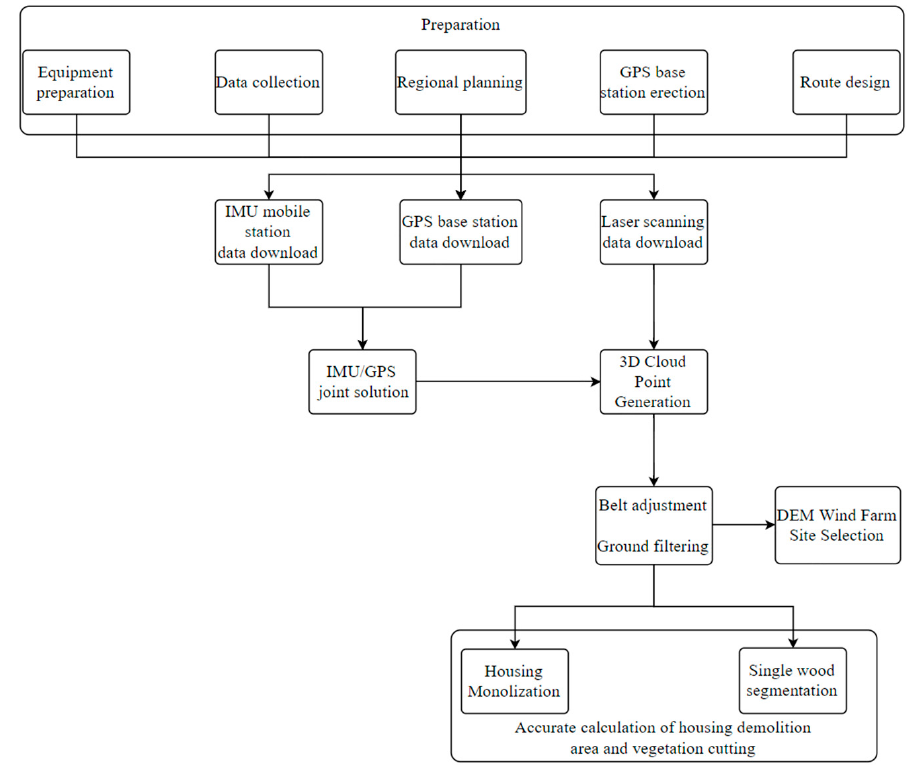
Figure 2. LiDAR work fl ow [2].